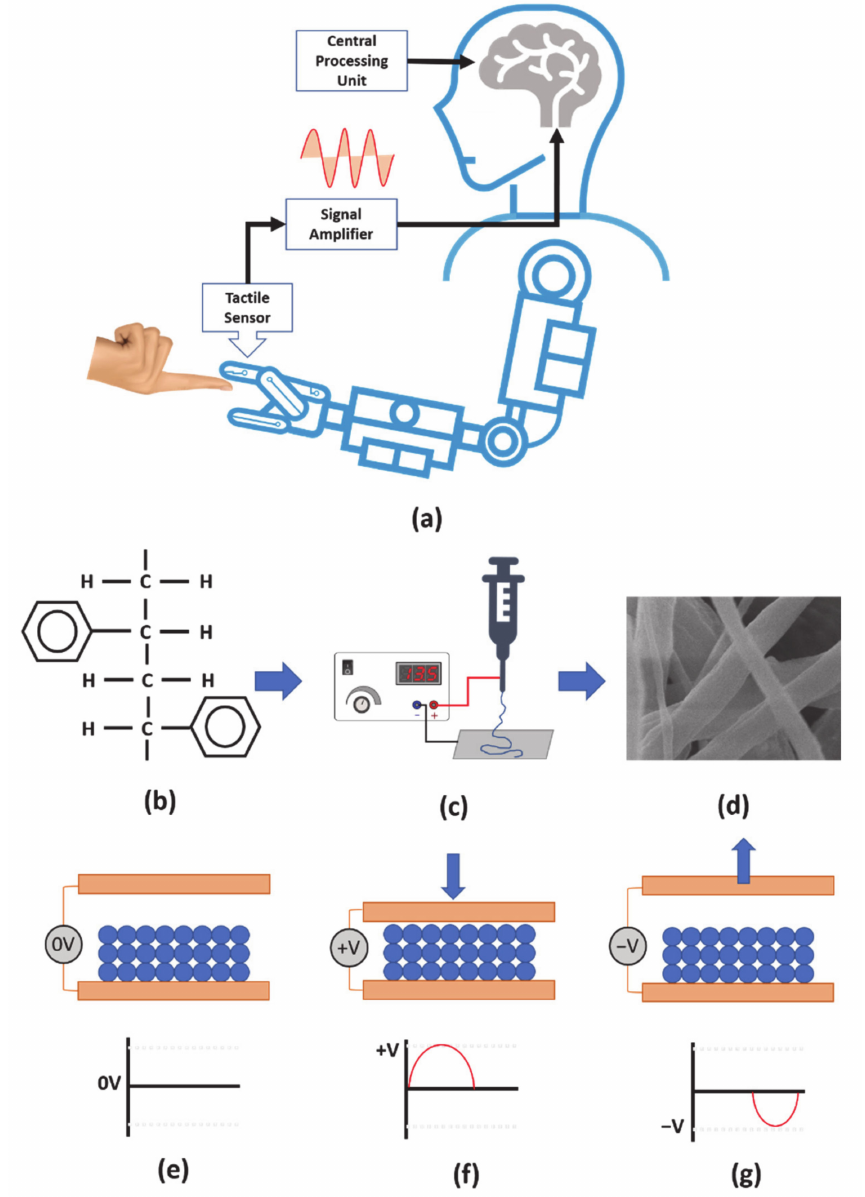
Figure 1. ( a ) Schematic illustration of a robot touch sensation. ( b ) Atactic polystyrene chain. ( c ) Elec- trospinning set-up. ( d ) SEM image of nanofibers. Schematics of tactile sensor ( e ) neutral, ( f ) com- pressed and ( g )